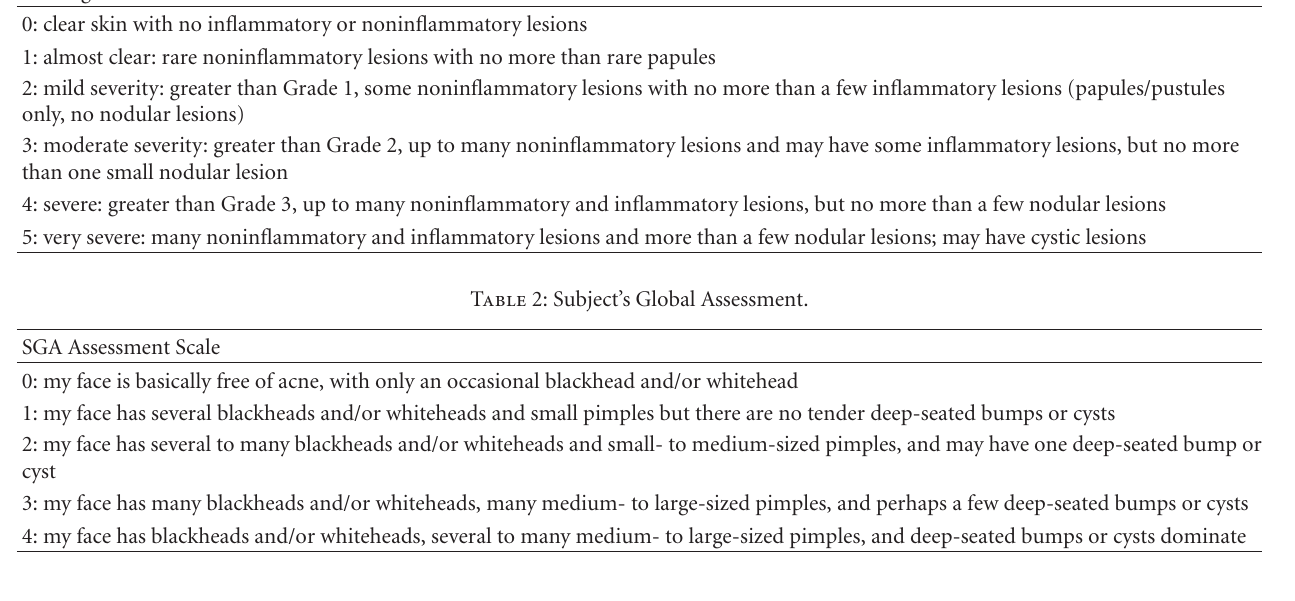
Table 3: Local tolerability